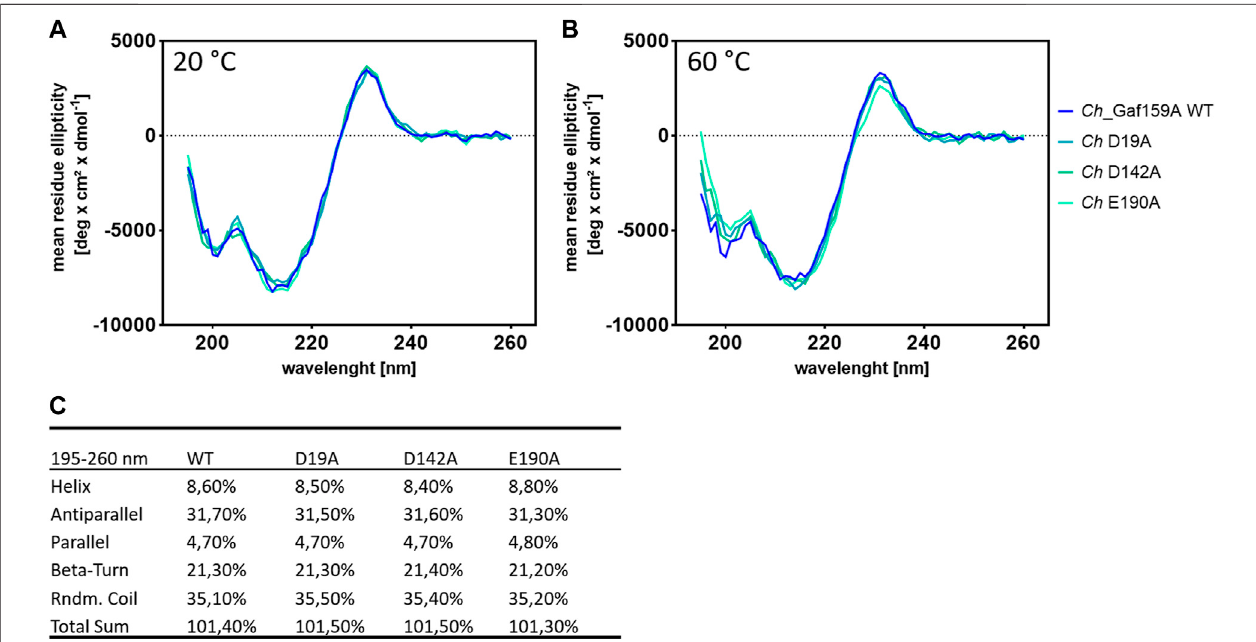
FIGURE 9 | Circular dichroism measurements for Ch _Gaf159A and its mutants Ch _D19A, Ch _D142A and Ch _E190A. CD spectra obtained at 20 ° C (A) and 60 ° C (B) and, secondary structure composition revealed by computational spectra analysis at 20 ° C (C) .